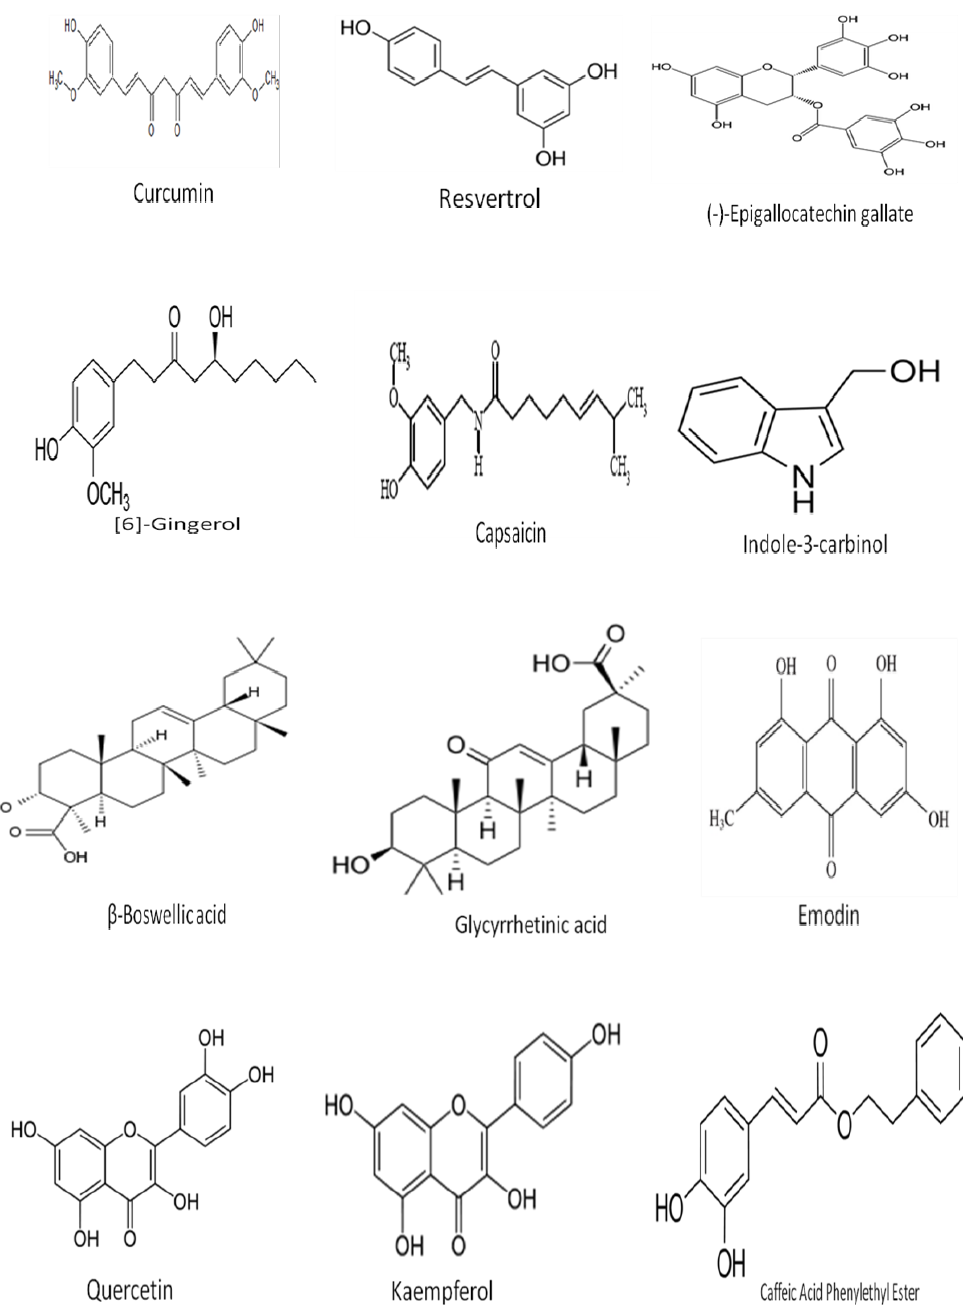
Figure 1. Chemical structure of selected active compounds derived from South Asian Medicinal Plants.